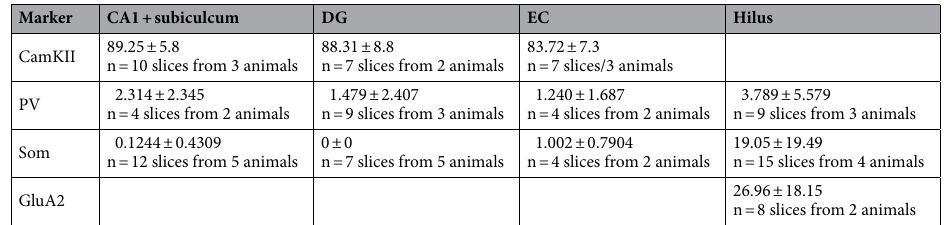
Table 1. Quantification of colocalization of tdTomato fluorescence with glutamatergic neuronal marker CamKII and GABAergic neuronal markers PV and Som. The values represent Mean ± SD of the percent tdTomato-expressing neurons that colocalized with the marker protein.